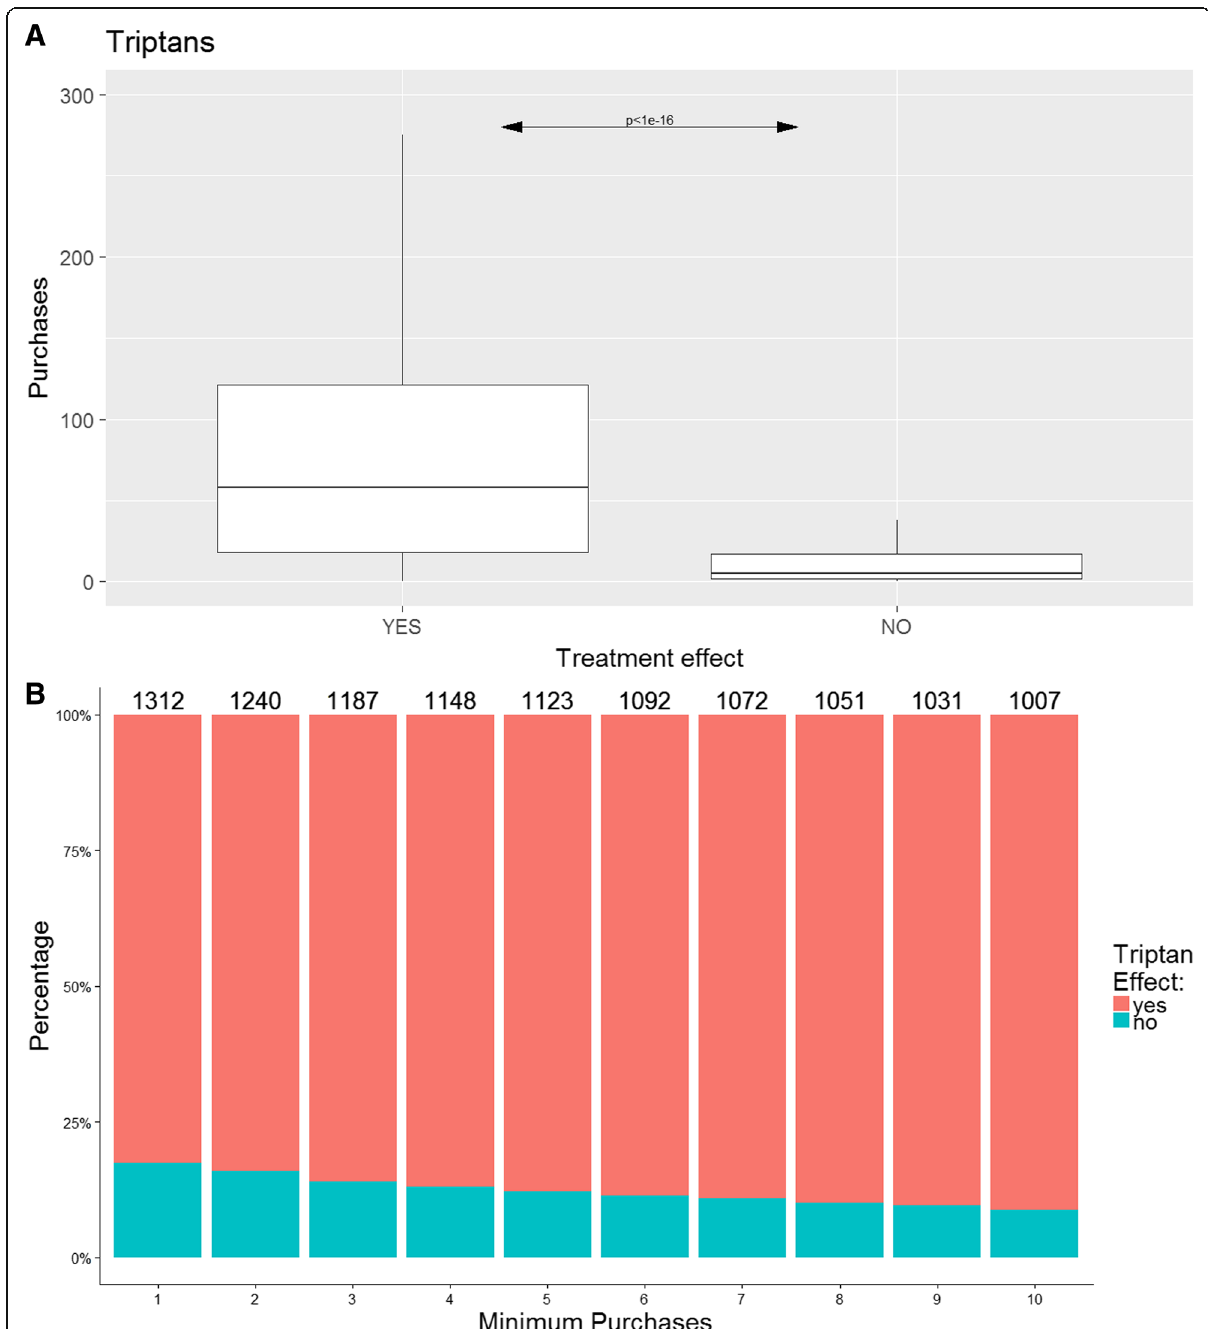
Fig. 1 Distribution of triptan purchases. The figure depicts the distribution of triptan purchases, a ) as a boxplot of individuals reporting a treatment effect of triptans (YES), no effect (NO) and b ) as stacked histograms showing the distribution of triptan effect among patients with a minimum number of purchases of triptans on the x-axis and the total number of patients above each bar. Since the Danish legislation does not allow depicting individual data, outliers are excluded in